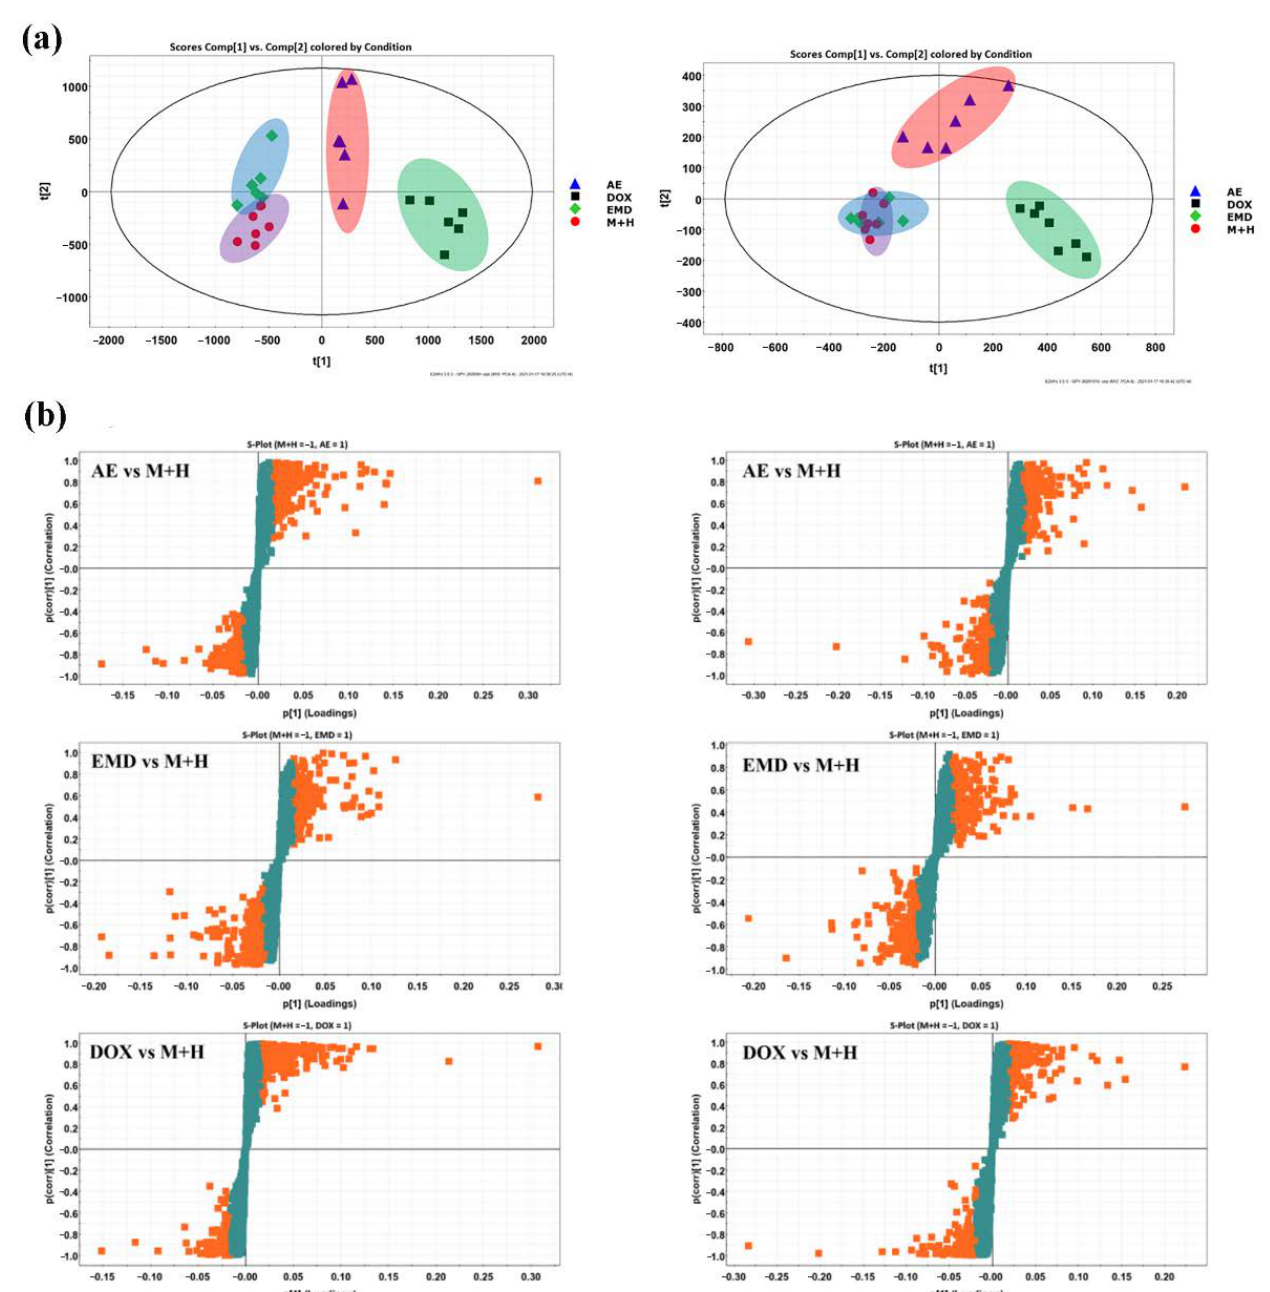
Figure 6. PCA score plots of aloe emodin (AE), emodin (EMD), doxorubicin (DOX), and control group (M + H) in positive ( left ) and negative ( right ) ion mode ( a ). S-polts of metabolic profiling between aloe emodin (AE)/emodin (EMD)/doxorubicin (DOX) and control group (M + H) in positive ( left ) and negative ( right ) ion modes. The orange and green cubes represent metabolites of VIP>1 and VIP<1, respectively ( b ).